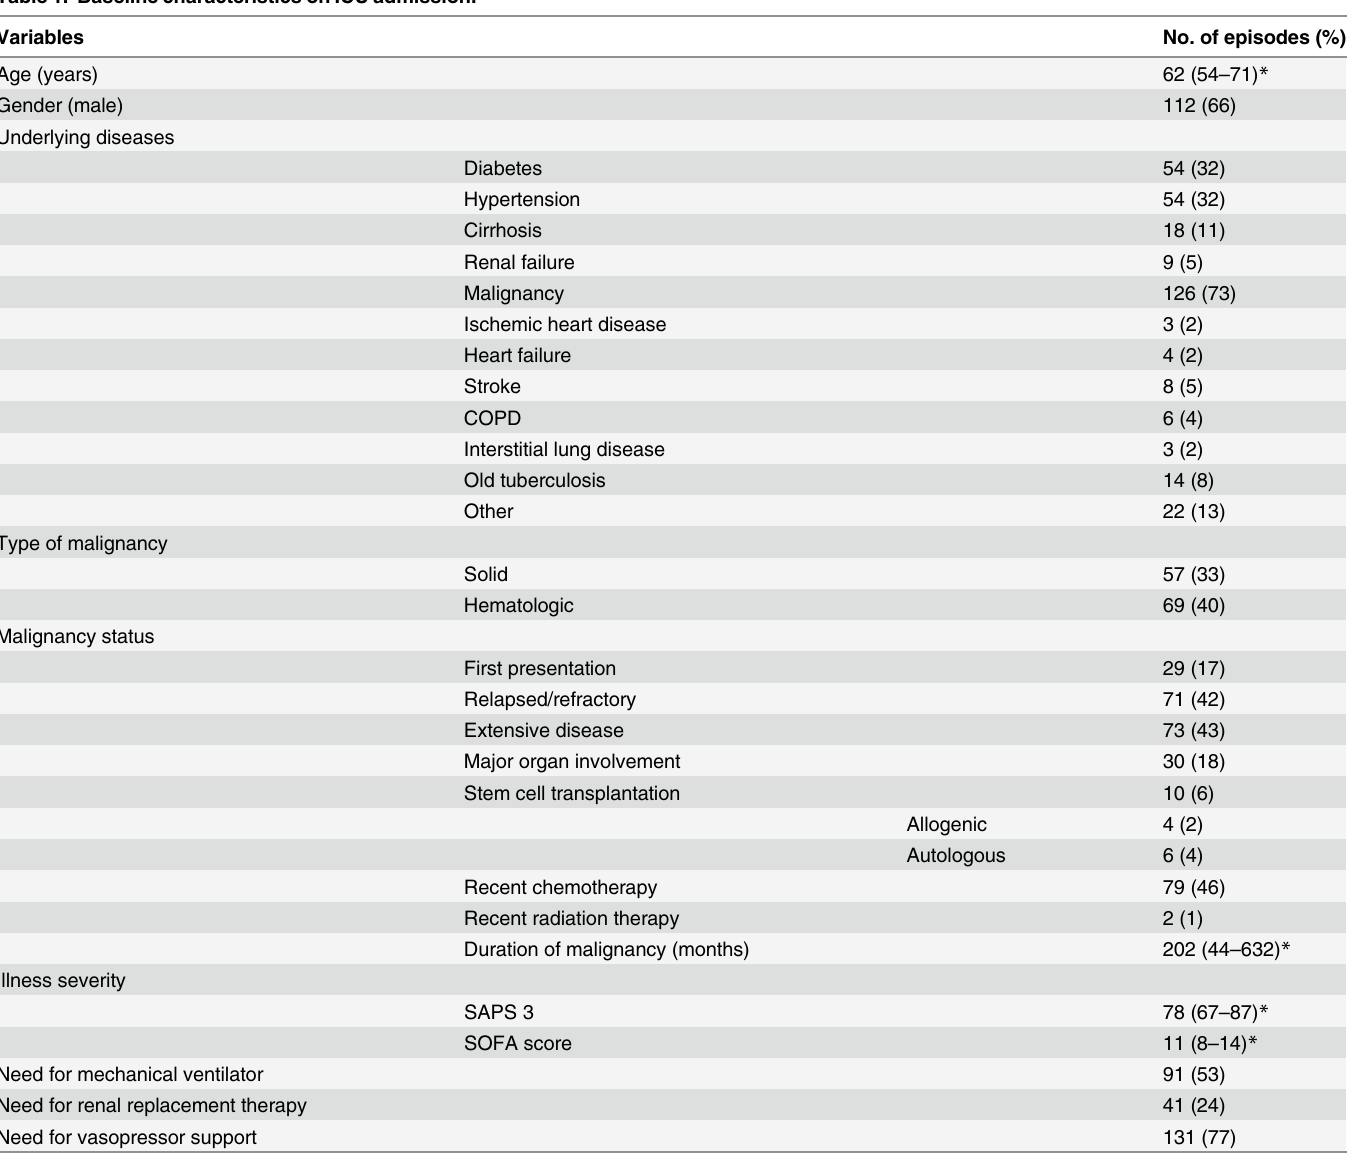
Table 1. Baseline characteristics on ICU